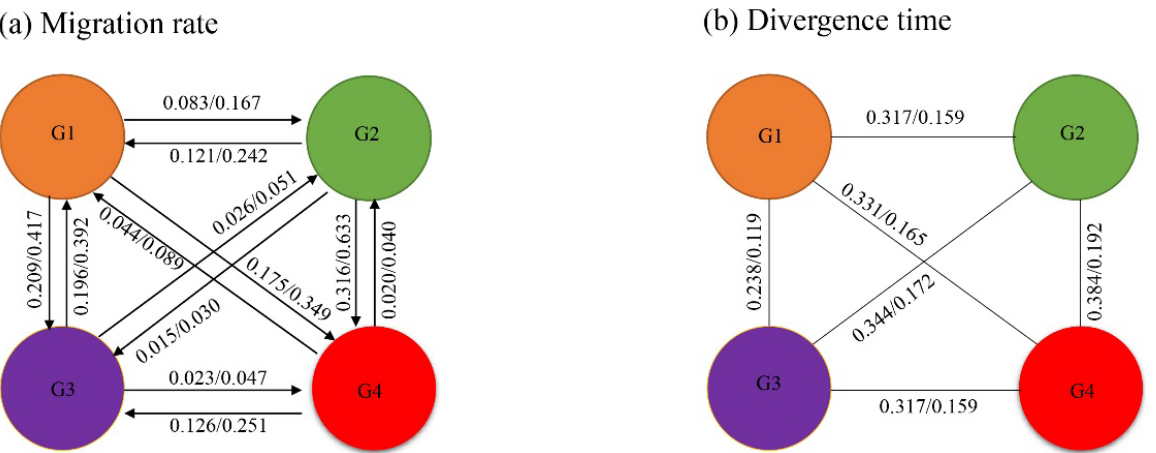
Figure 4. Historical immigration rates ( a ) and divergence times ( b ) between the four defined mito- chondrial haplotype groups (G1–G4) as derived from the mitochondrial network. Immigration rates ( a ) and divergence times ( b ) were inferred based on concatenated mitochondrial loci (MCR) with a substitution rates of 0.756% (left) and 1.513%